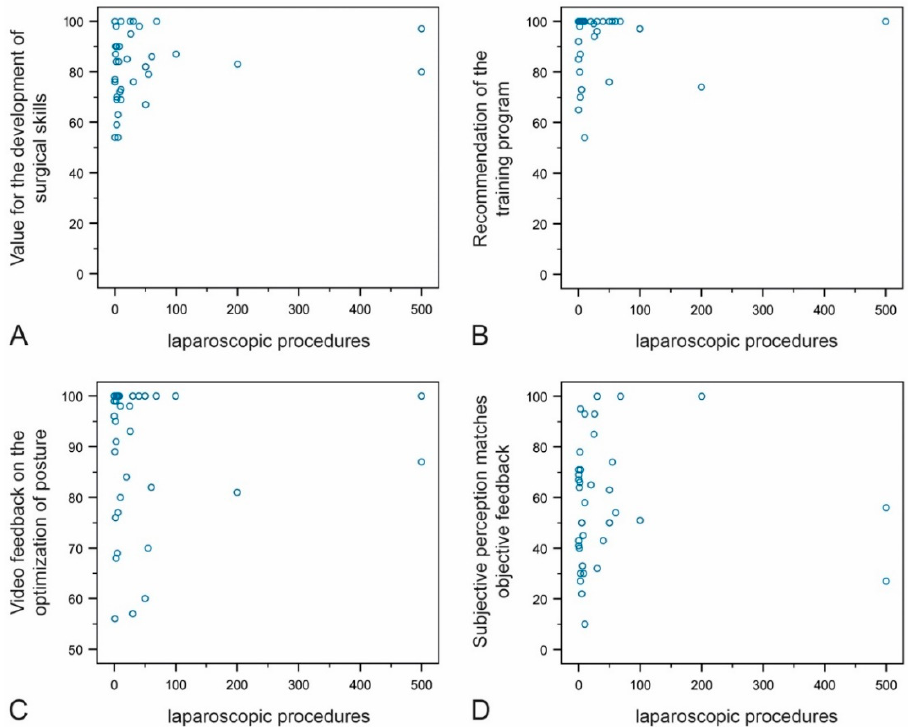
Figure 8. Correlation of the number of laparoscopic interventions and the value of the course for the development of surgical skills ( A ), the recommendation of video feedback training ( B ), the benefit of video feedback for posture ( C ), and whether the attendees’ subjective assessment is equivalent to the experts’ objective feedback ( D ). One attendee who had performed 2000 procedures was not listed. Table 3. Comments given by participants to the open questions in the